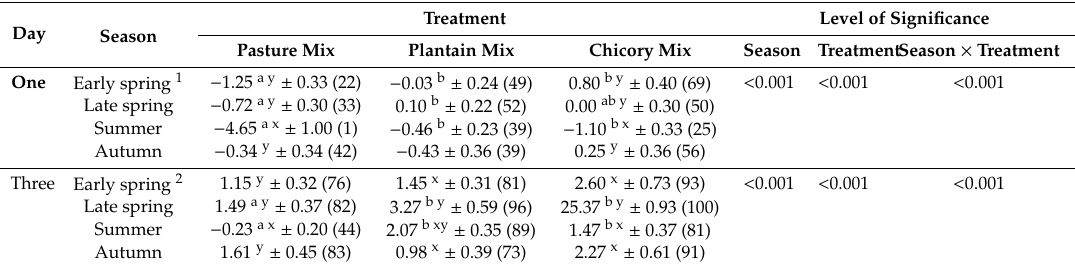
Table 6. Proportional selection of tagged white clover by lambs across all the seasons between treatments (pasture mix vs. plantain mix vs. chicory mix) (logit lsmeans ± SEM, back transformed percentages (%) are given in